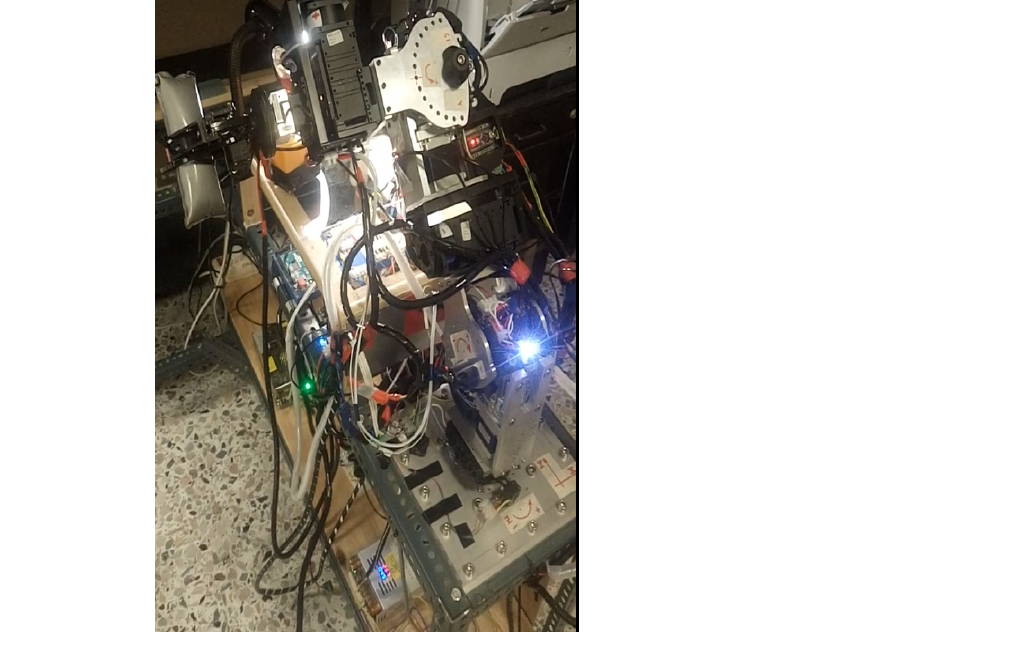
Figure 17. Optimal anatomy of the metamorphic manipulator derived under the effective mass and MMA measure for Task 2.